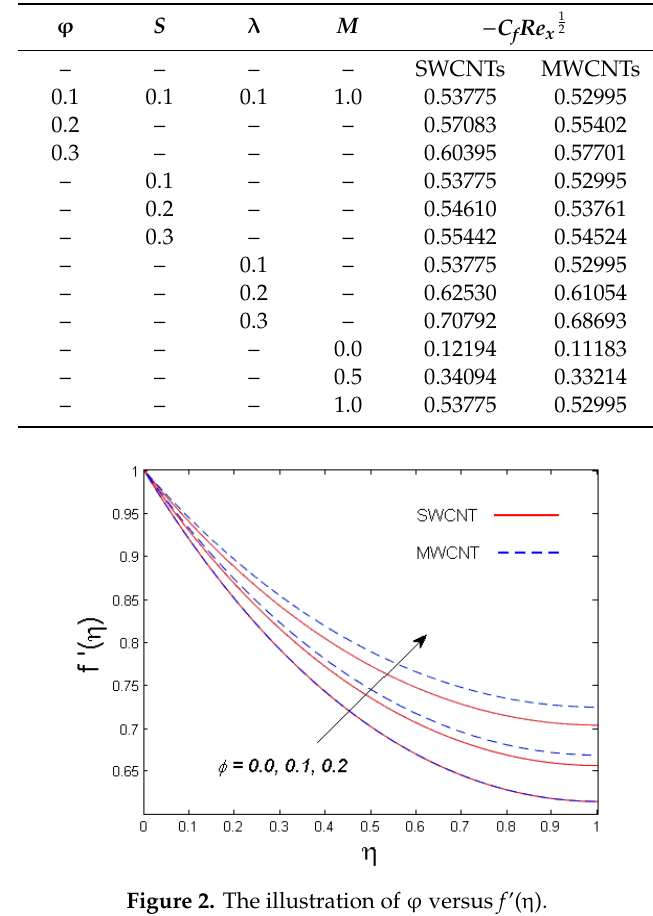
Table 4. The numerical value of the Skin friction with P r = 6.2.